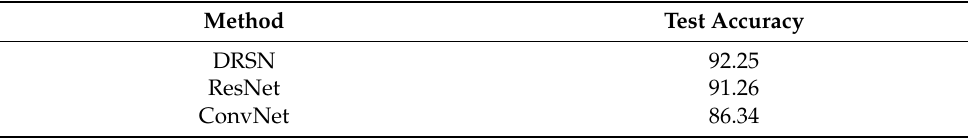
Table 4. Average accuracies of the DRSN, ResNet and ConvNet with Gaussian noise (%).